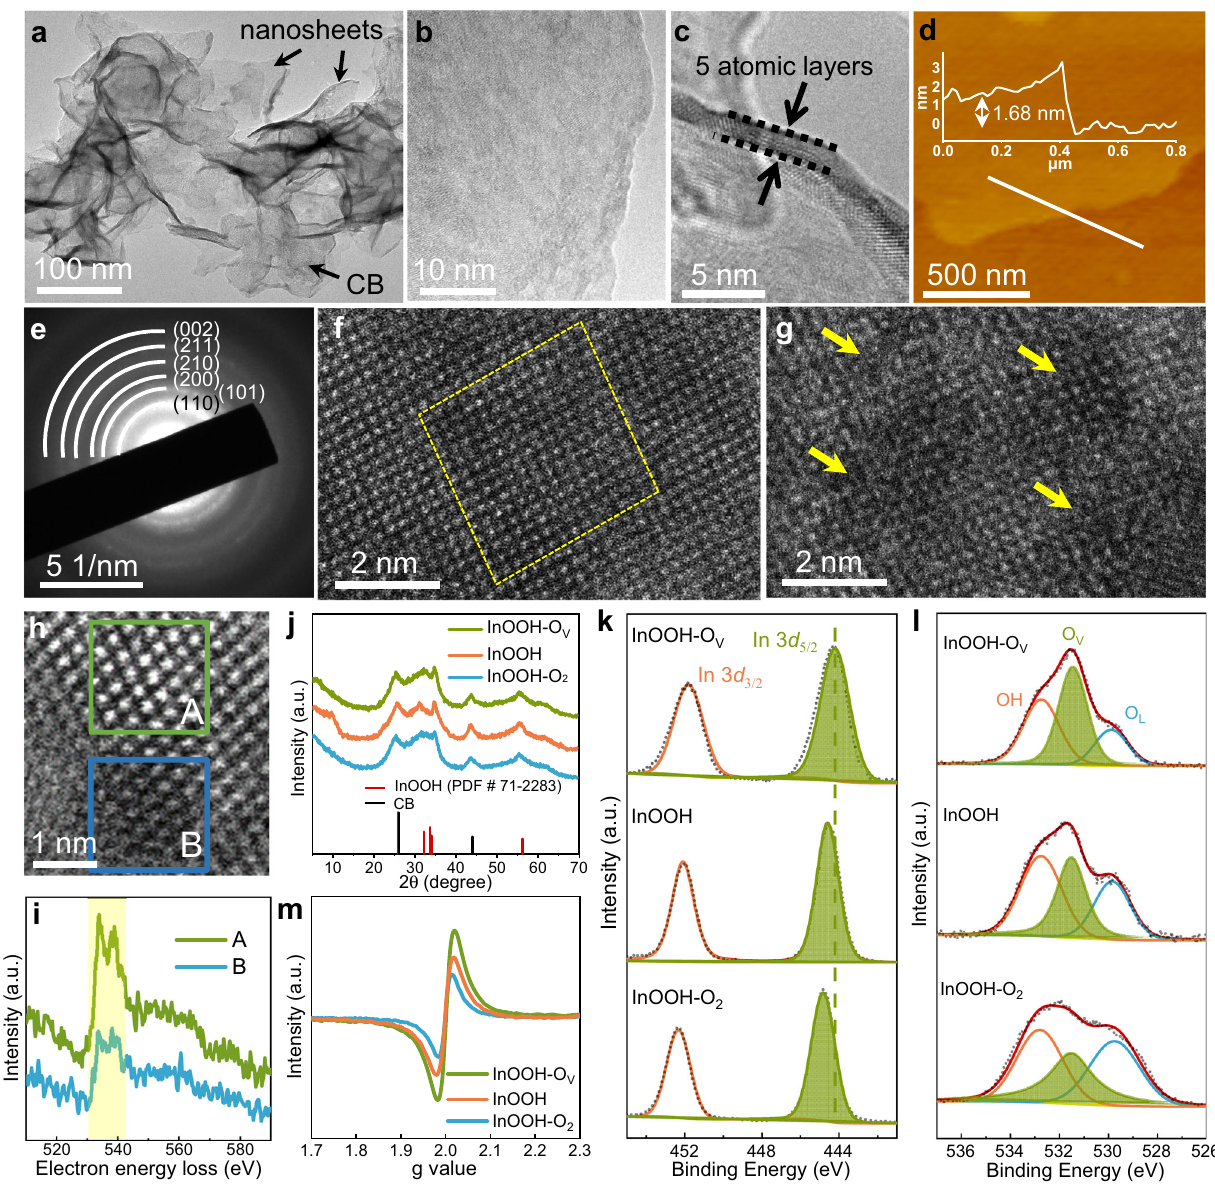
Fig. 2 | Physical characterization. a, b TEM, c HR-TEM, and d AFM images of InOOH-O V . e SAED pattern of of InOOH-O V . Atomic-resolution HAADF-STEM images of f typical intact InOOH nanosheets and g InOOH-O V . h HAADF-STEM image within